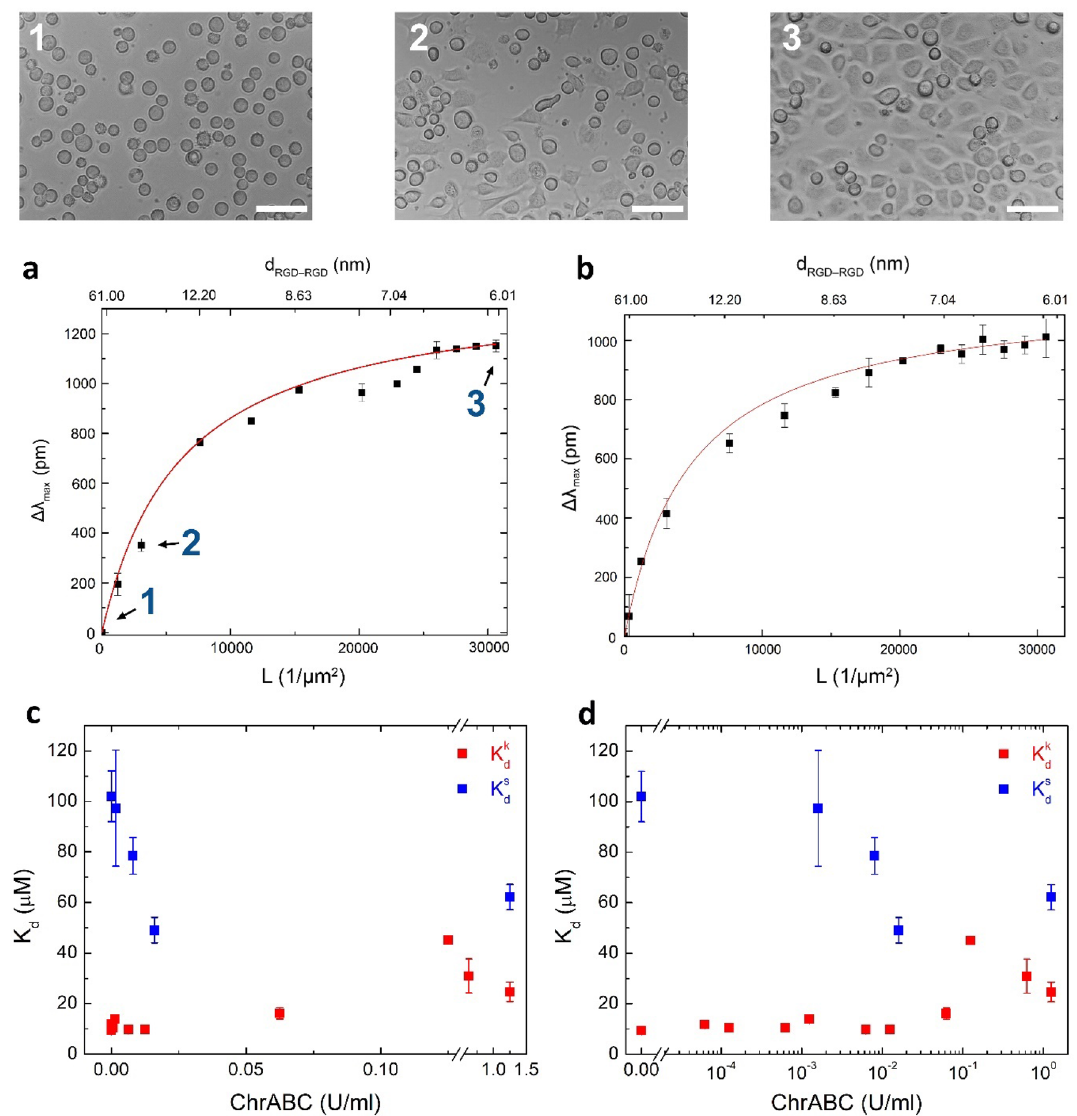
Figure 9. ( a ) Saturation level biosensor data of cell adhesion measured on the RGD-tuned surfaces without enzyme treatment. Microscope images represent adhered cells at three different ligand densities. (Scale bar: 100 µm). The continuous line represents the fit of the employed receptor-ligand binding model (see text for details). ( b ) Maximum wavelength shift as a function of average number of ligands per unit area when HeLa cells were treated with 0.008 U/ml ChrABC and adhered on the surfaces. (The continuous lines represents the fit of the employed receptor-ligand binding model (see text for details). ( c ) Comparison of the obtained “static” and “kinetic” dissociation constants of integrin-RGD binding measured at various enzyme